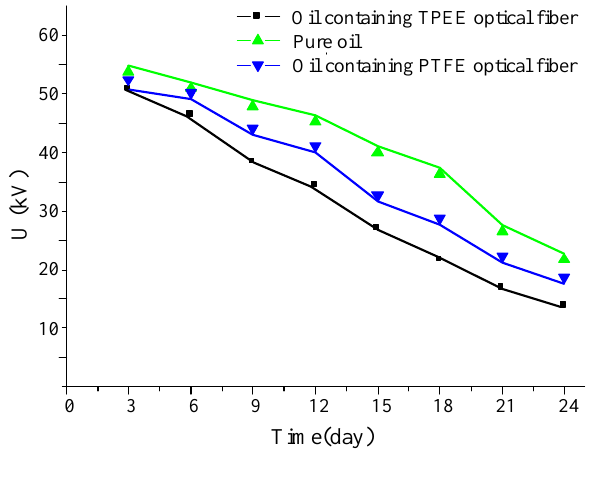
Figure 3. Breakdown voltage of oil.